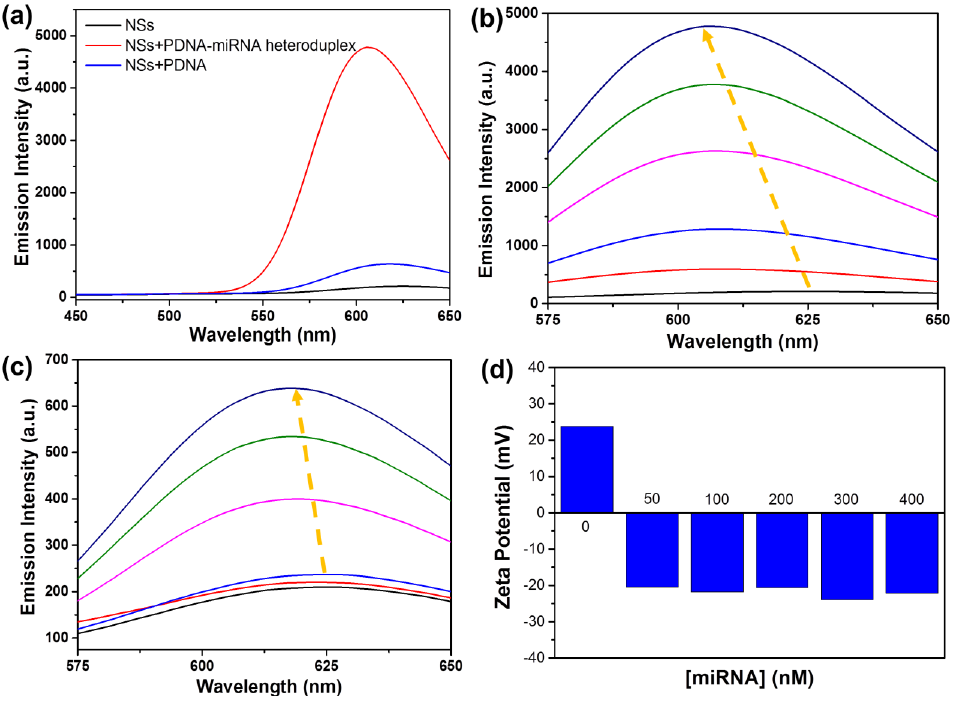
Figure 3. ( a ) The fluorescence spectral changes of the dispersed EB − TAPB − TFP NSs with and without addition of PDNA and PDNA − miRNA heteroduplex. ( b ) Changes in the emission ( λ ex = 350 nm) of EB − TAPB − TFP NSs upon addition of PDNA − miRNA heteroduplex with various concentrations from 0 to 400 nM. ( c ) Changes in the emission ( λ ex = 350 nm) of EB − TAPB − TFP NSs upon addition of PDNA with various concentrations from 0 to 400 nM. ( d ) Changes in zeta potential value of EB − TAPB − TFP NSs upon increasing the concentration of PDNA − miRNA heteroduplex.